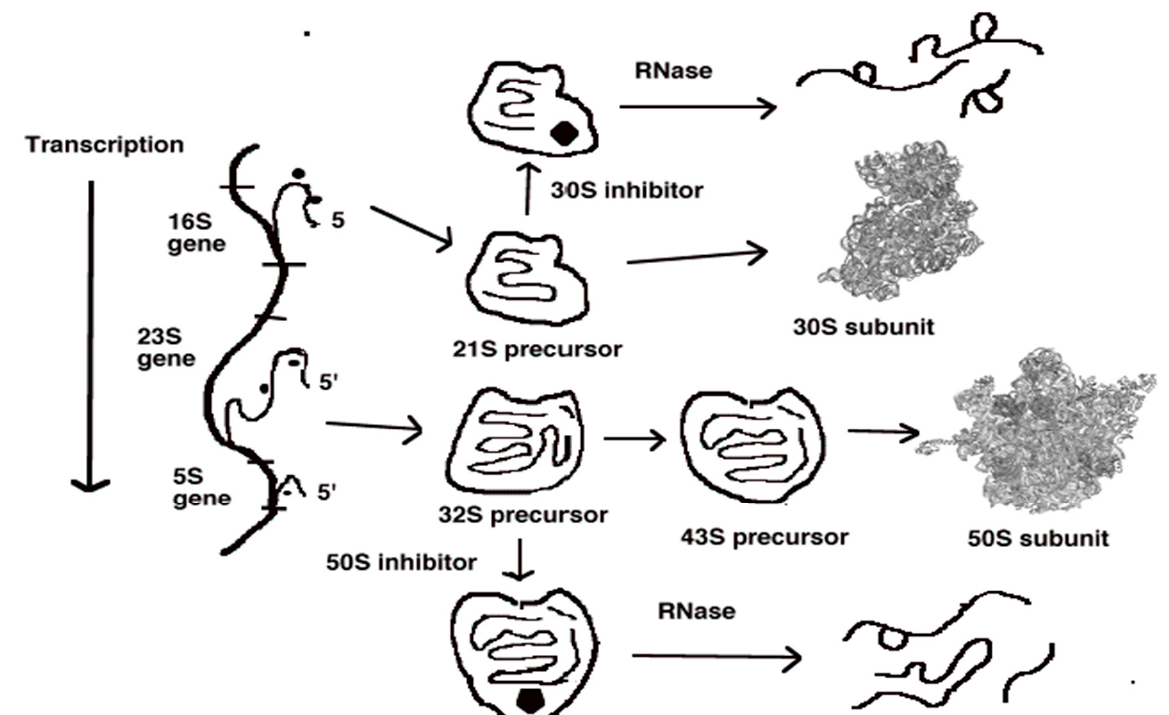
Figure 1. A model for ribosomal subunit assembly and inhibition by antibiotics. 16S rRNA transcription followed by ribosomal protein addition gives a 21S precursor particle, which adds additional proteins to yield 30S subunits. Transcription of 23S and 5S rRNA is followed by the formation of both 32S and 43S intermediates, which lead to 50S subunit formation after specific ribosomal protein addition. In the presence of antibiotics, assembly stalls at the first defined intermediate particle, which can bind the appropriate antibiotic. Ribonucleases degrade the stalled intermediate particle, reducing net subunit formation. Note that 16S rRNA transcription and 30S assembly precede 23S and 5S rRNA transcription and 50S assembly [9].